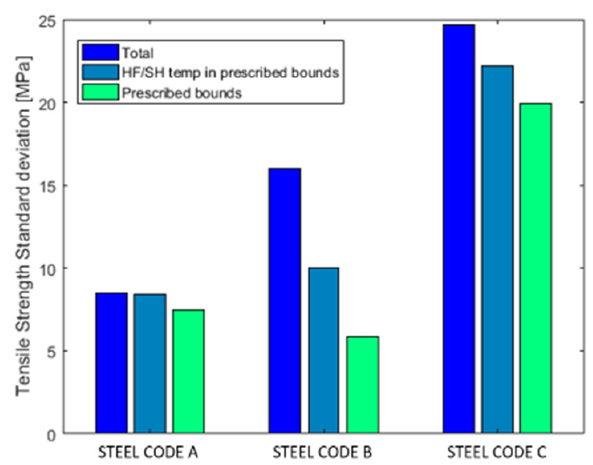
Figure 4. Results of the offline test concerning the standard deviation of R m .